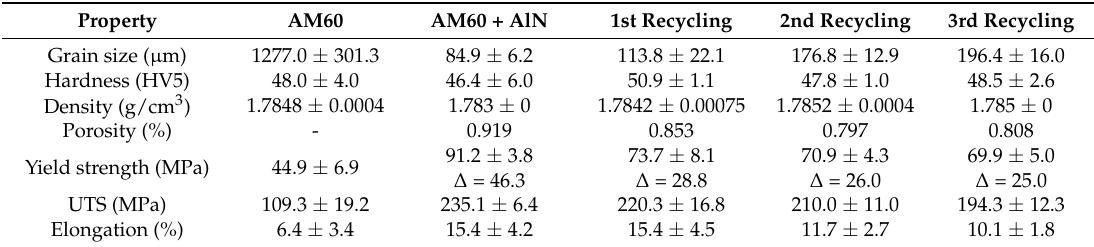
Table 1. Grain size, hardness, density, percent porosity, and the mechanical properties of the investigated materials. UTS = ultimate tensile strength.